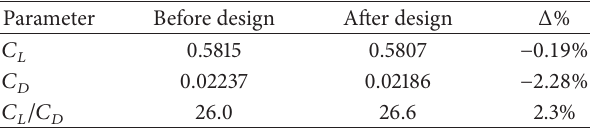
Table 6: Optimization results of flexible